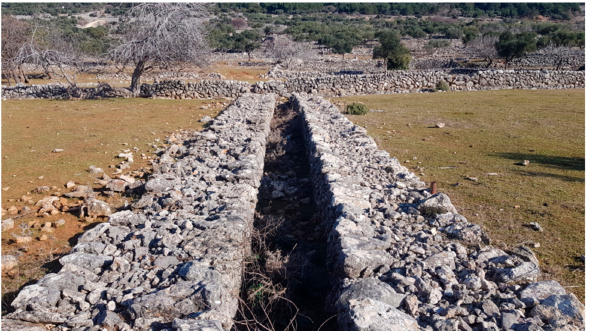
Figure 21. The dry stone channels serve to direct the water from the heavy rainfalls and flooding (Tanja Kremeni´c, 2020).